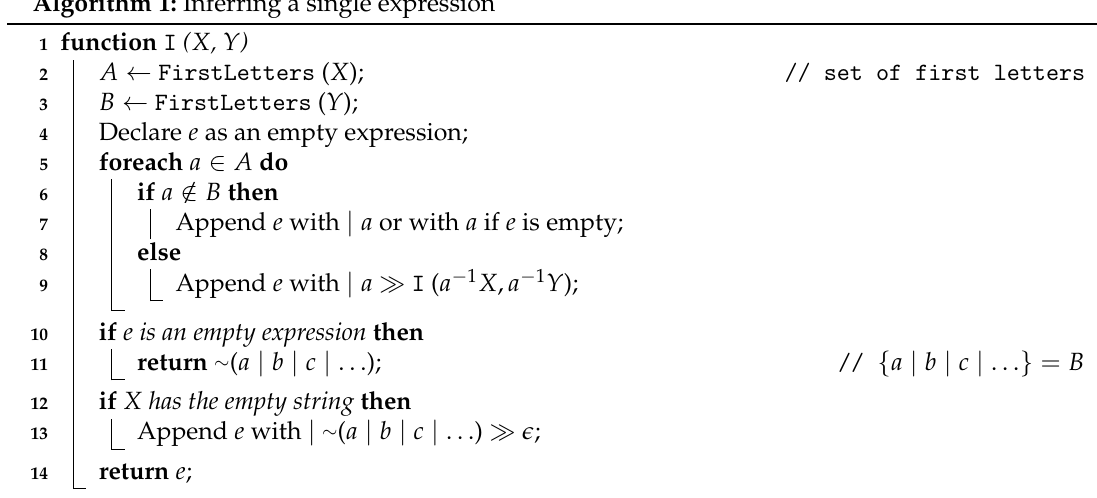
Algorithm 1: Inferring a single